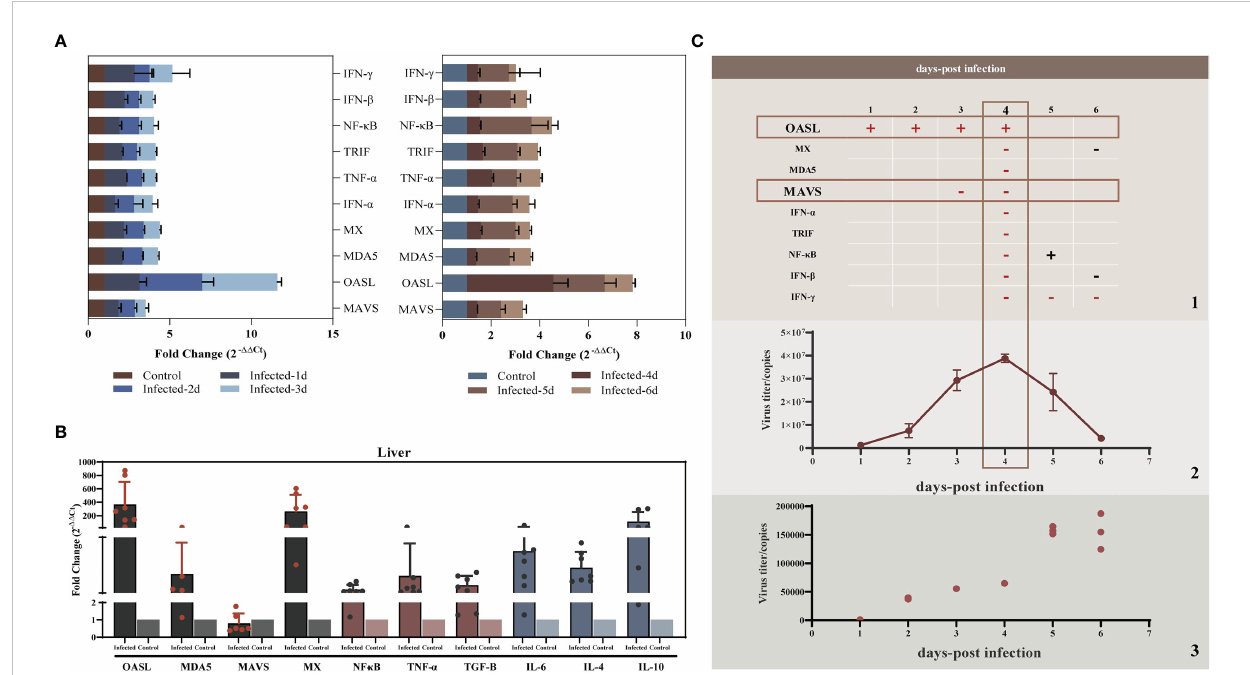
FIGURE 3 YT strain – triggered innate immune responses in vitro and in vivo . (A) Transcriptional levels of MDA5 , OASL , MX , MAVS , IFN- a , TRIF , NF- k B , IFN- b , and TNF- a associated with innate immunity in LMH cell were analyzed at 24, 48, 72, 96, 120, and 144 hpi. (B) Transcriptional levels of MDA5, OASL, MX, MAVS, NF- k B, and TNF- a in SPF chicken liver. (C) Association between viral replication trends and antiviral proteins. (C.1) The red rectangles mark the two antiviral proteins with signi fi cant differences of upregulated (OASL) or downregulated (MAVS) expression levels for the corresponding time points. The “ + ” represent upregulated, and the “ − ” represents downregulated. (C.2) The copy number of viral RNA that was present in the LMH cell. (C.3) The copy number of viral RNA that was present in the cell culture